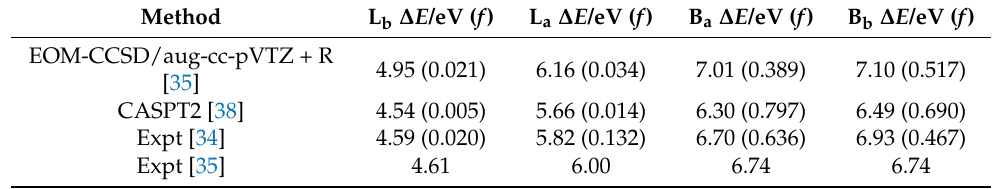
Table 1. Experimental [34,35] and computed [34,38] electronic transition energies ( ∆ E ) and oscillator strengths ( f ) of the singlet excitations of phenol, which were labeled following Platt’s notation.